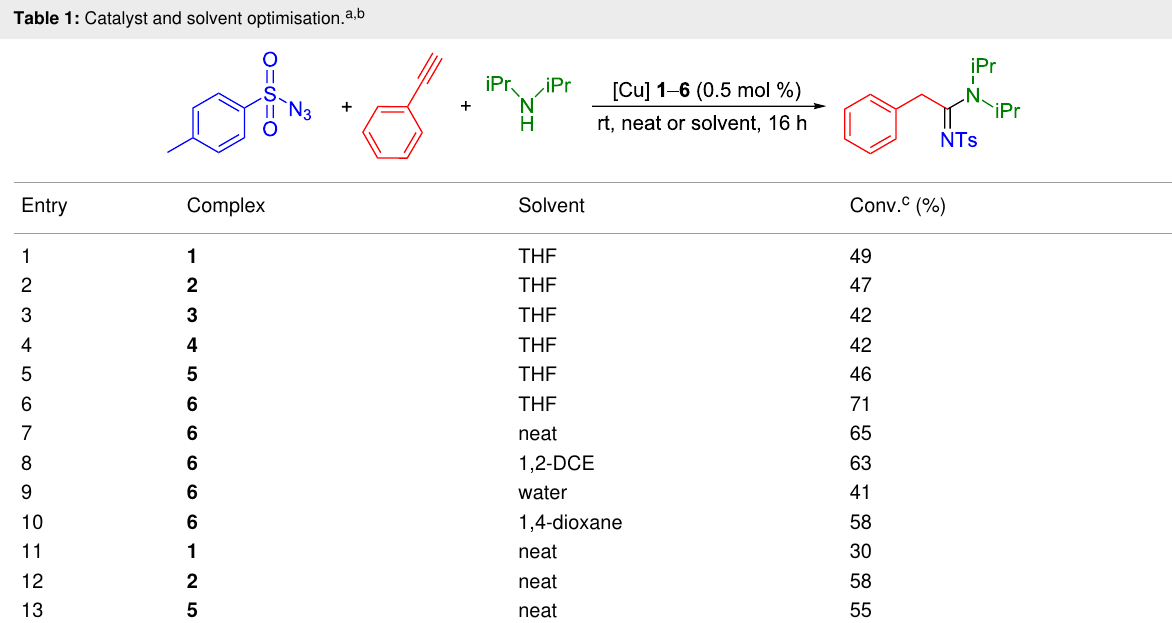
Table 1: Catalyst and solvent optimisation.